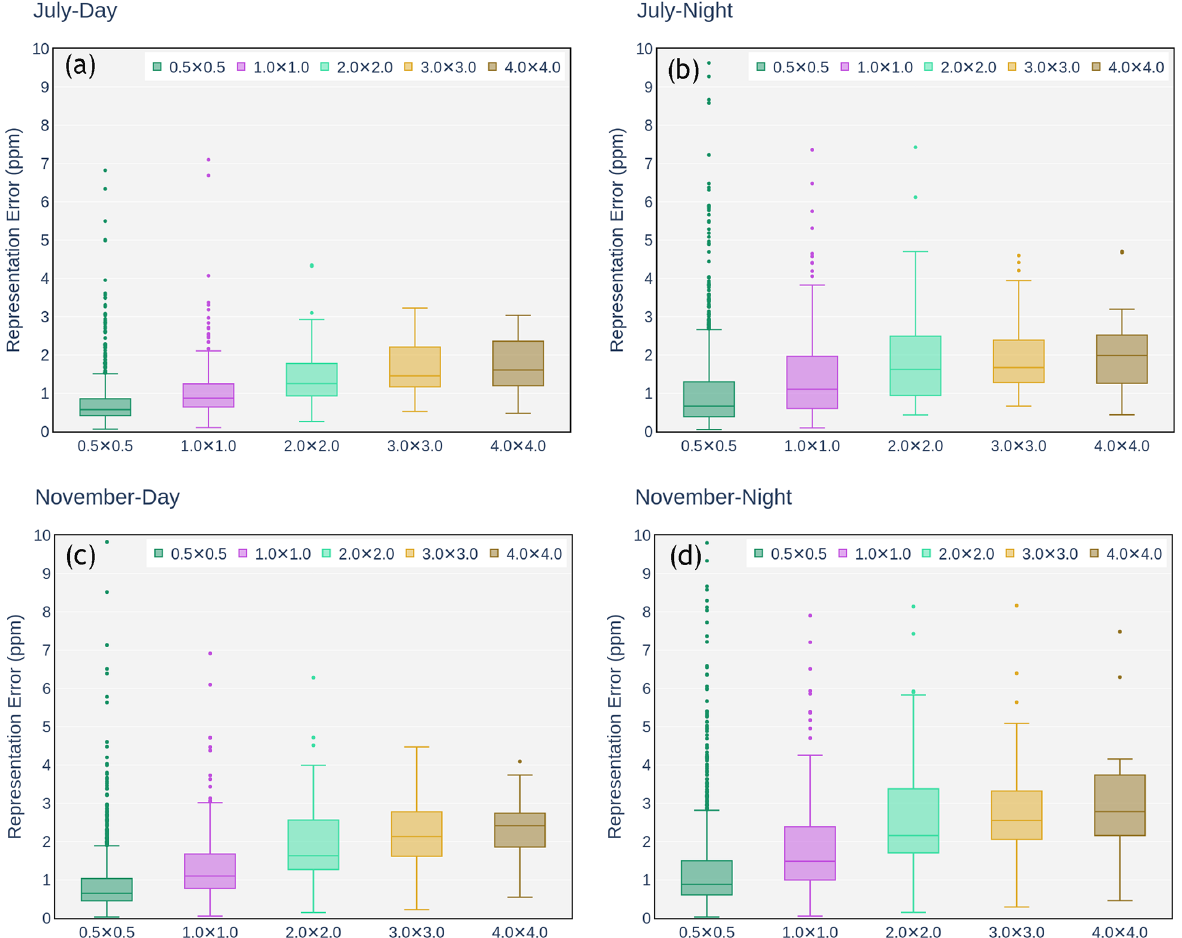
Figure 7. Variability in derived surface representation error over India for different horizontal resolutions. Boxes indicate the central 50%, the bar across the box is median value, and the whiskers indicate the value between the 5th and 95th percentiles. Individual data points shown are the outliers. (a) Representation error estimated for July daytime. (b) July nighttime. (c) November daytime. (d) November